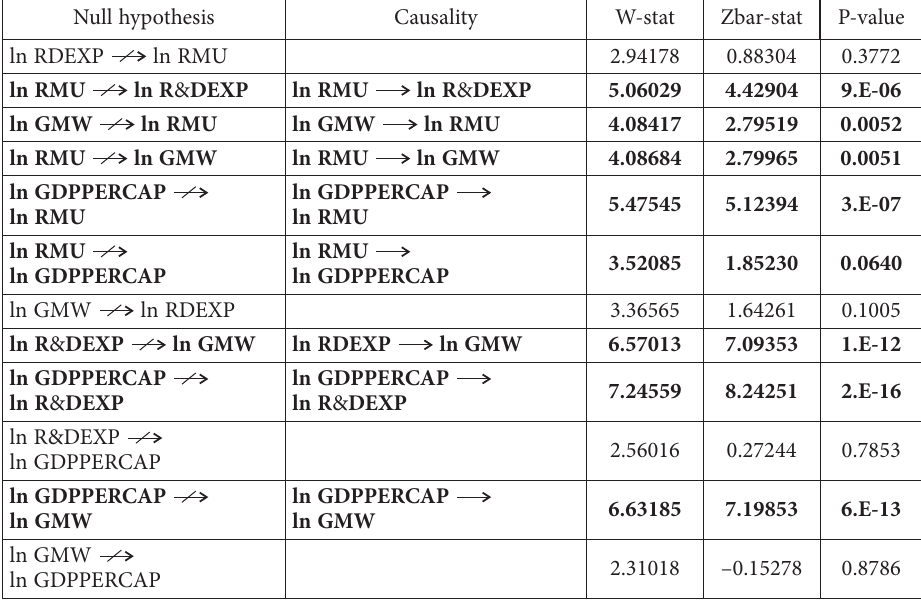
Table 12. Summary of the Dumitrescu–Hurlin panel causality